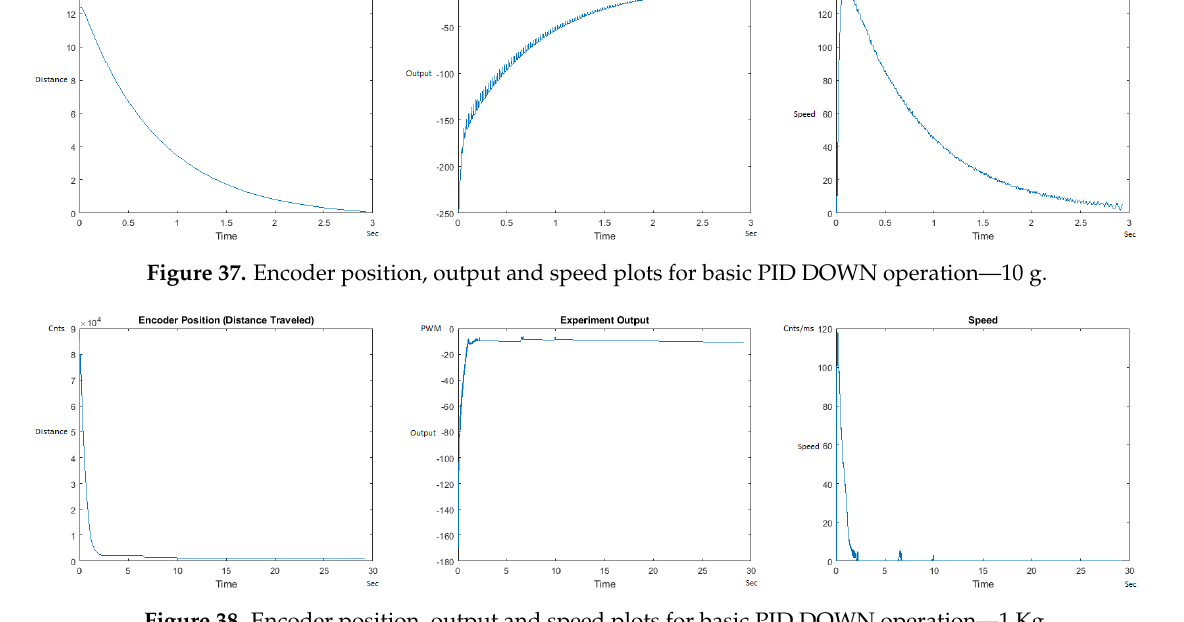
Figure 38. Encoder position, output and speed plots for basic PID DOWN operation—1